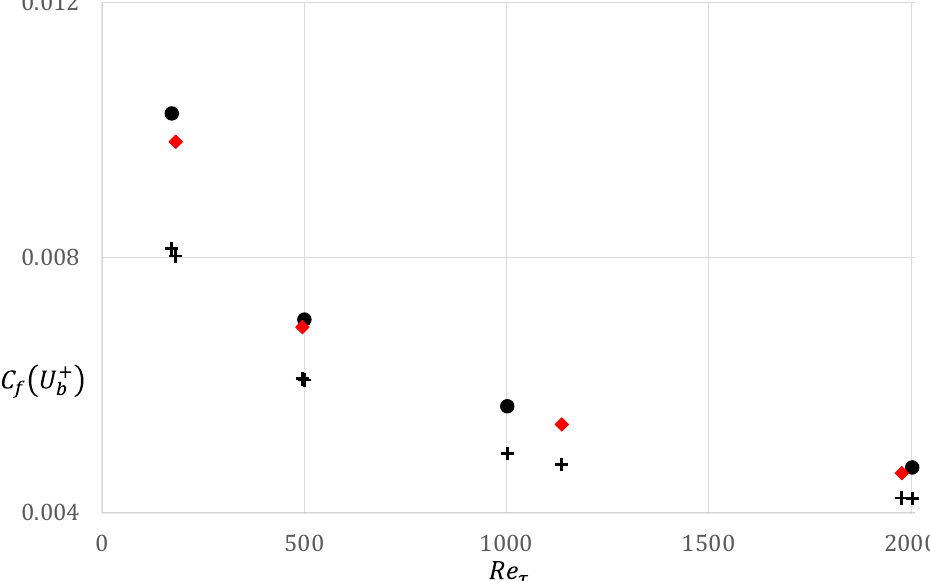
(cid:0) (cid:1) U b + ; • pipe DNS data [26]; (cid:7) pipe DNS data [31,32]; and + channel ITM. Figure 12. Figure 12. C f